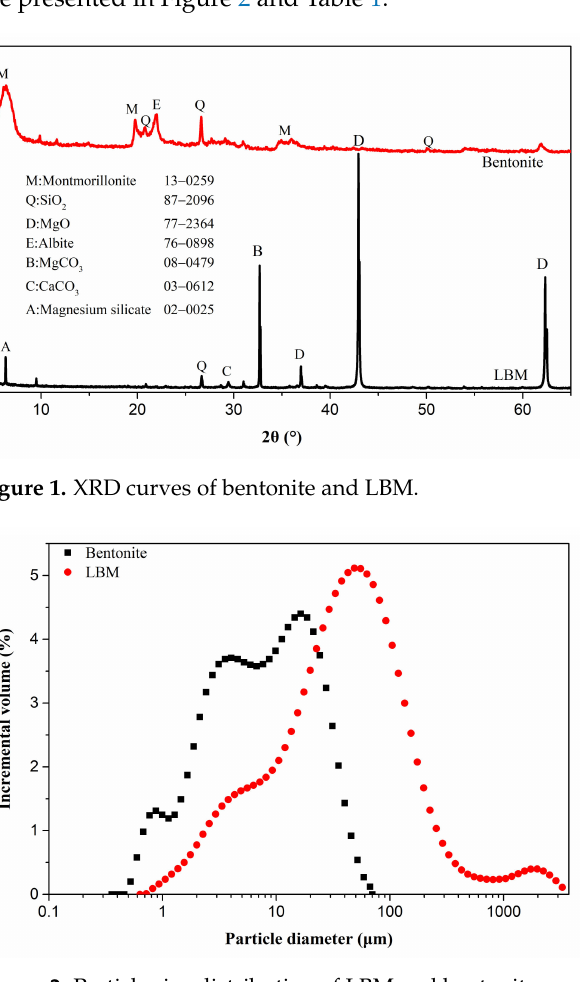
Figure 2. Particle size distribution of LBM and bentonite. Table 1. Chemical composition of LBM and